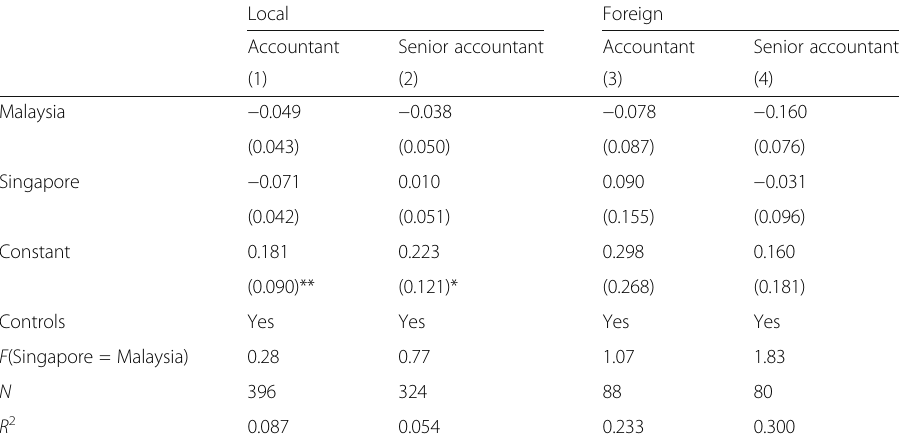
Table 5 Dependent variable: if a resume is the first to receive a callback for an interview (accountant)